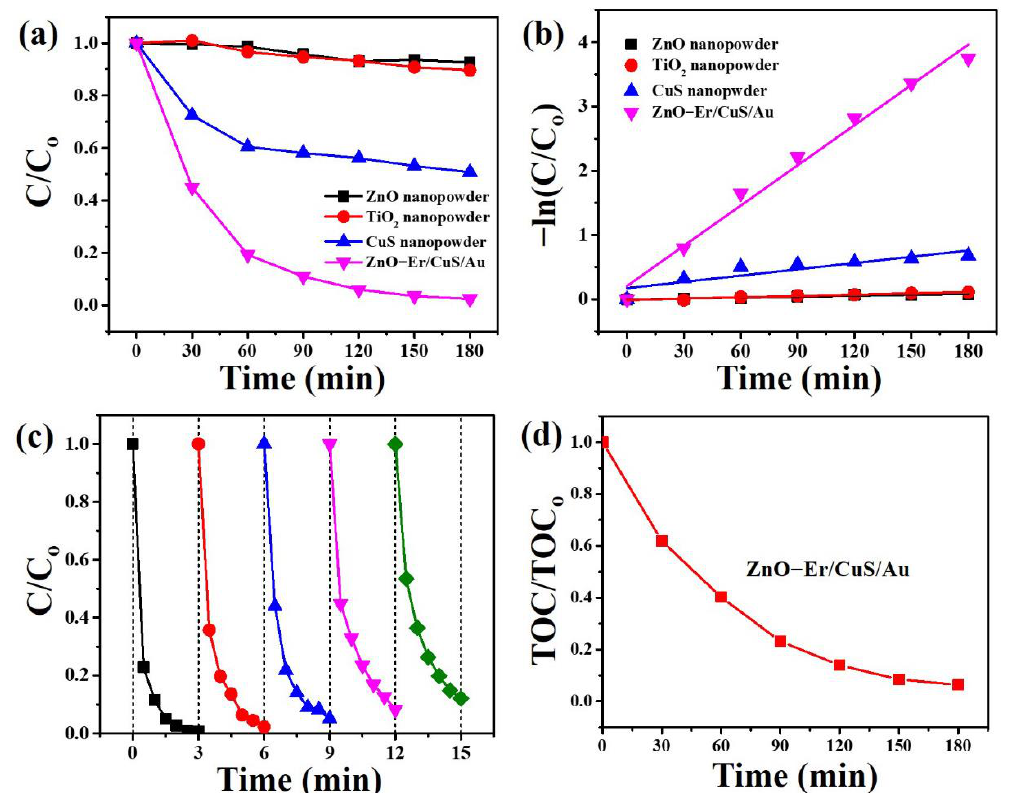
Figure 7. ( a ) Photocatalytic activities and ( b ) kinetic linear simulation curves of as-prepared and commercial photocatalysts under blue LED light. ( c ) The reusability of the Er-doped ZnO/CuS/Au core-shell nanowires under blue LED light. ( d ) The total organic carbon of AO7 solution with Er-doped ZnO/CuS/Au core-shell nanowires as a function of irradiation time.